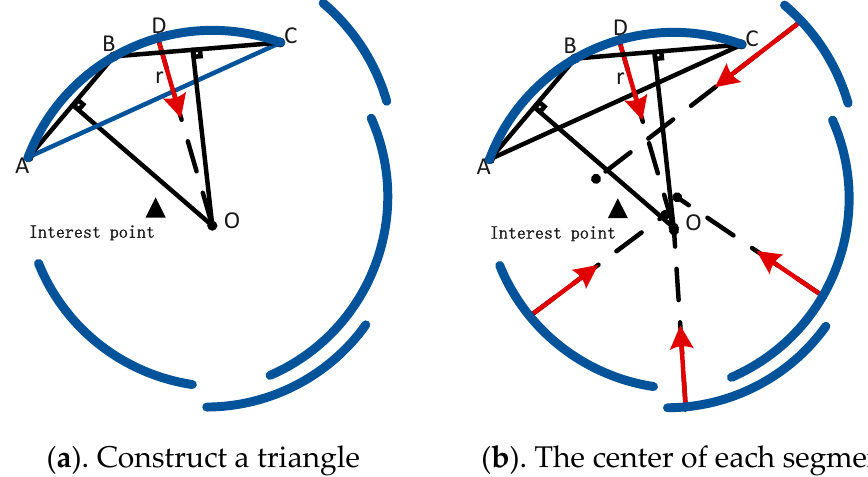
Figure 7. The centroid point of the contour segment is calculated. The direction vector is represented by the red arrow.